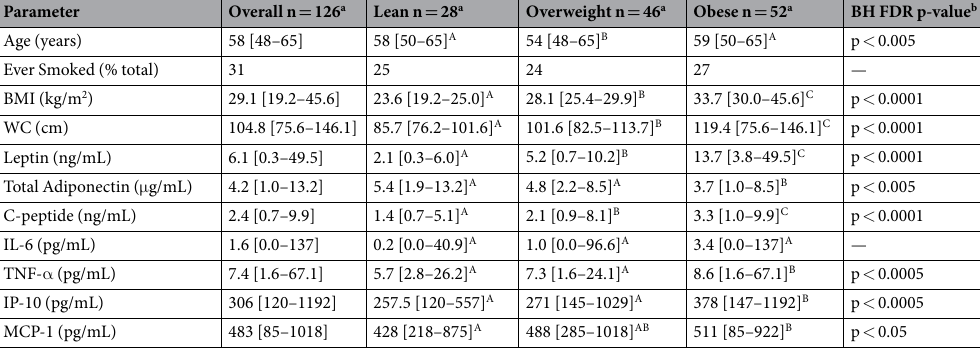
Table 1. Median [range] of the participant characteristics, in the sample, and divided by BMI category. Body mass index (BMI), waist circumference (WC), tumor necrosis factor-alpha (TNF- α ), interferon gamma- induced protein-10 (IP-10), interleukin-6 (IL-6), monocyte chemoattractant protein-1 (MCP-1). a Values expressed as median [range]. Cytokines quantified from serum. b Kruskall Wallis one-way ANOVA was conducted across BMI categories along with Dunn’s test for multiple comparison. The superscripted letters A, AB, B, and C represent the multiple comparison test for each parameter for the lean, overweight, and obese categories. P-values were adjusted using Benjamini-Hochberg false discovery rate (BH FDR)